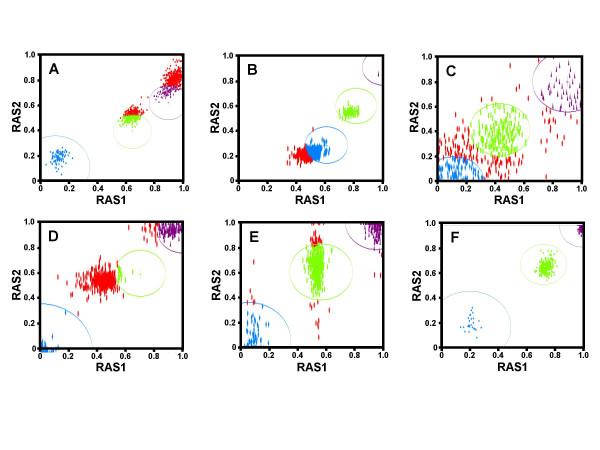
A graphical representation of the performance of 6 example SNPs for 948 individuals. Screen shots of the call zones (ellipses) and respective calls (solid shapes) for select SNPs from 948 individual genotypes. Blue represents call zone and calls of "B/B", Green represents "A/B", and Purple represents "A/A". Red represents those individuals that produced a "No Call" for the SNP. RAS1 and RAS2 scores are indicated on the x and y-axis respectively. Panel (a) SNP_A-1517236 and (b) SNP_A-1510986 represent SNPs with tightly clustered RAS scores, but inadequately trained call zones. An infrequently called SNP (SNP_A-1606312) with no systematic explanation is illustrated in panel c. Some SNPs cluster tightly at their RAS2 values, but have widespread RAS1 values (SNP_A-1513739) as in panel d. The opposite effect is seen in panel e (SNP_A-1508518). Panel f shows a SNP that is called >99% of the time (SNP_A-1511517) in these 948 individuals.